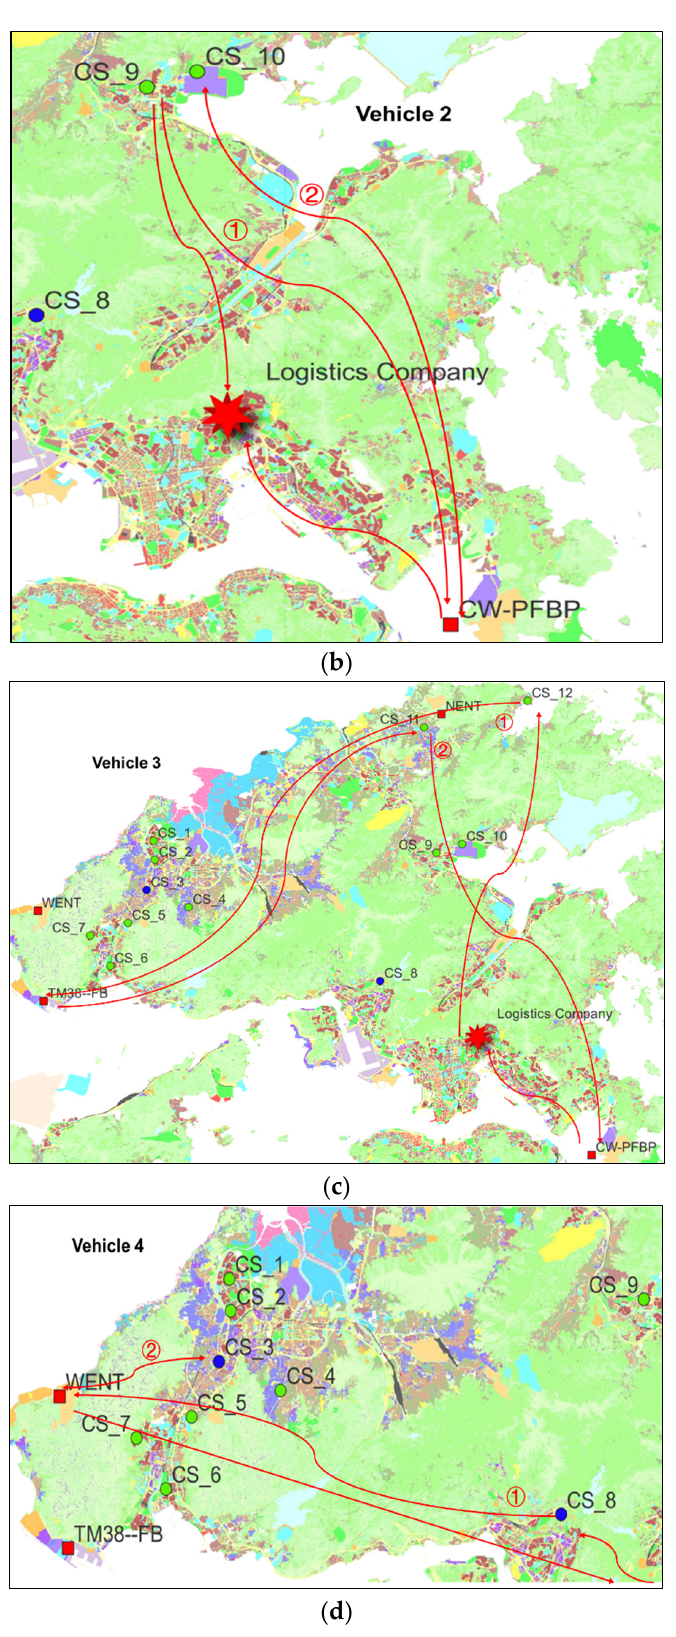
Figure 3. The optimal results. ( a ) The traveling route of vehicle 1; ( b ) the traveling route of vehicle 2; ( c ) the traveling route of vehicle 3; ( d ) the traveling route of vehicle 4. Vehicle 1 serves six CSs that all generate type 1 construction waste and transports all waste to DF 2 (i.e., TM38-FB). We know that the DFs available for Vehicle 1 are DF 1 and DF 2